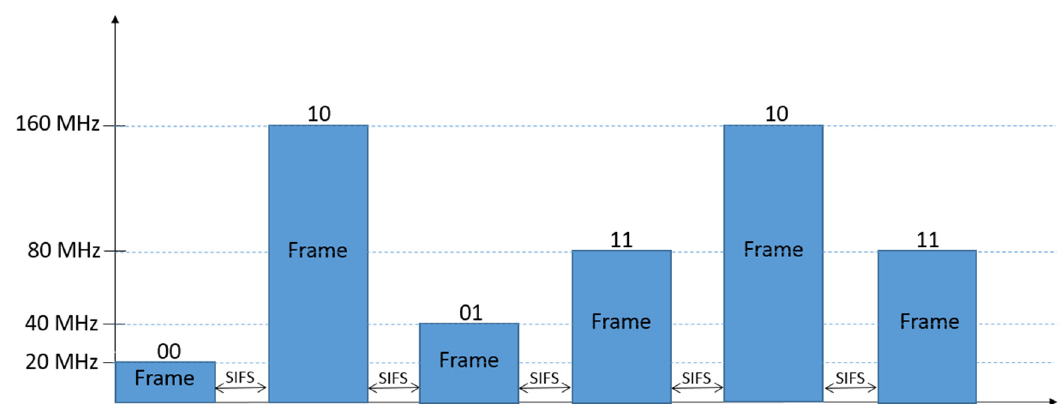
Figure 4. Example of two bits per symbol coding with four different signal bandwidths. A frame with 20 MHz of signal bandwidth representing bits “00”, a frame using 40 MHz represents bits “01”, 80 MHz corresponds to “11”, and 160 MHz to “10”.